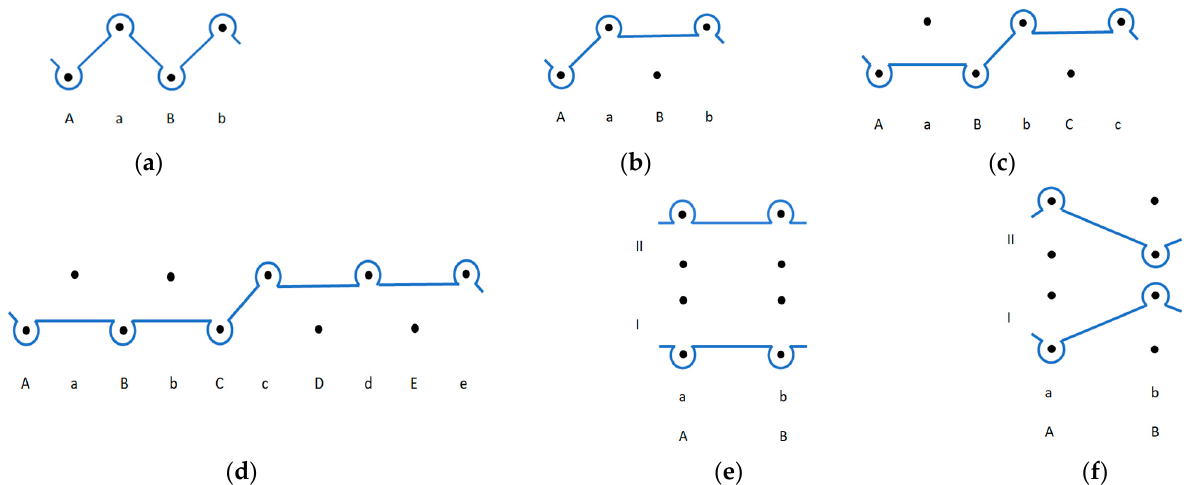
Figure 4. Graphic notation of the investigated structures: ( a ) rib 1 × 1; ( b ) rib 1 × 2; ( c ) rib 2 × 2; ( d ) rib 3 × 3; ( e ) purl 1 × 1; ( f ) moss-stitch purl.